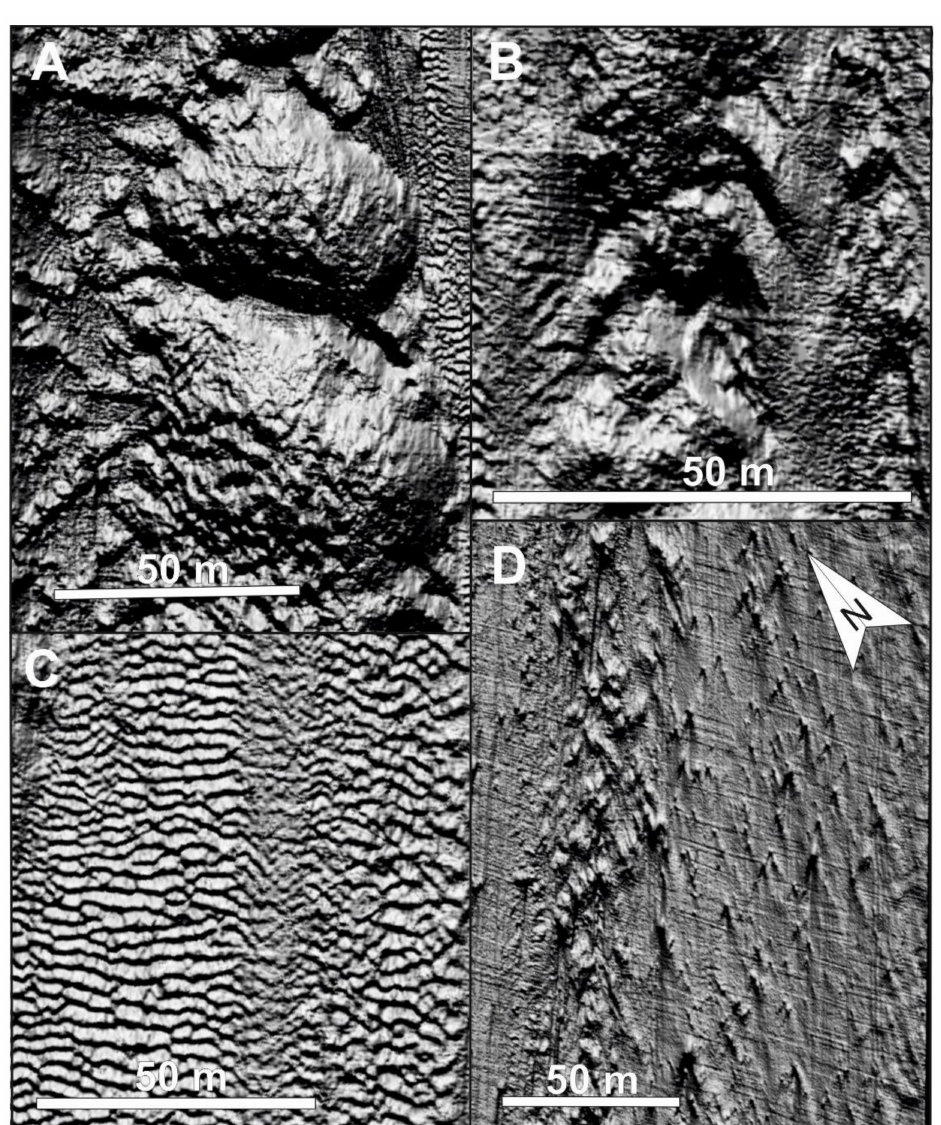
Figure 6. Some features observed in the bathymetry from October 2018. ( A ) Detail of attached bulges. ( B ) Relief of the lineal ridge consisting of attached cones separated by depressions. ( C ) Bedform field (3D dunes). ( D ) Erosive features with debris of residual origin. The north arrow is valid for all